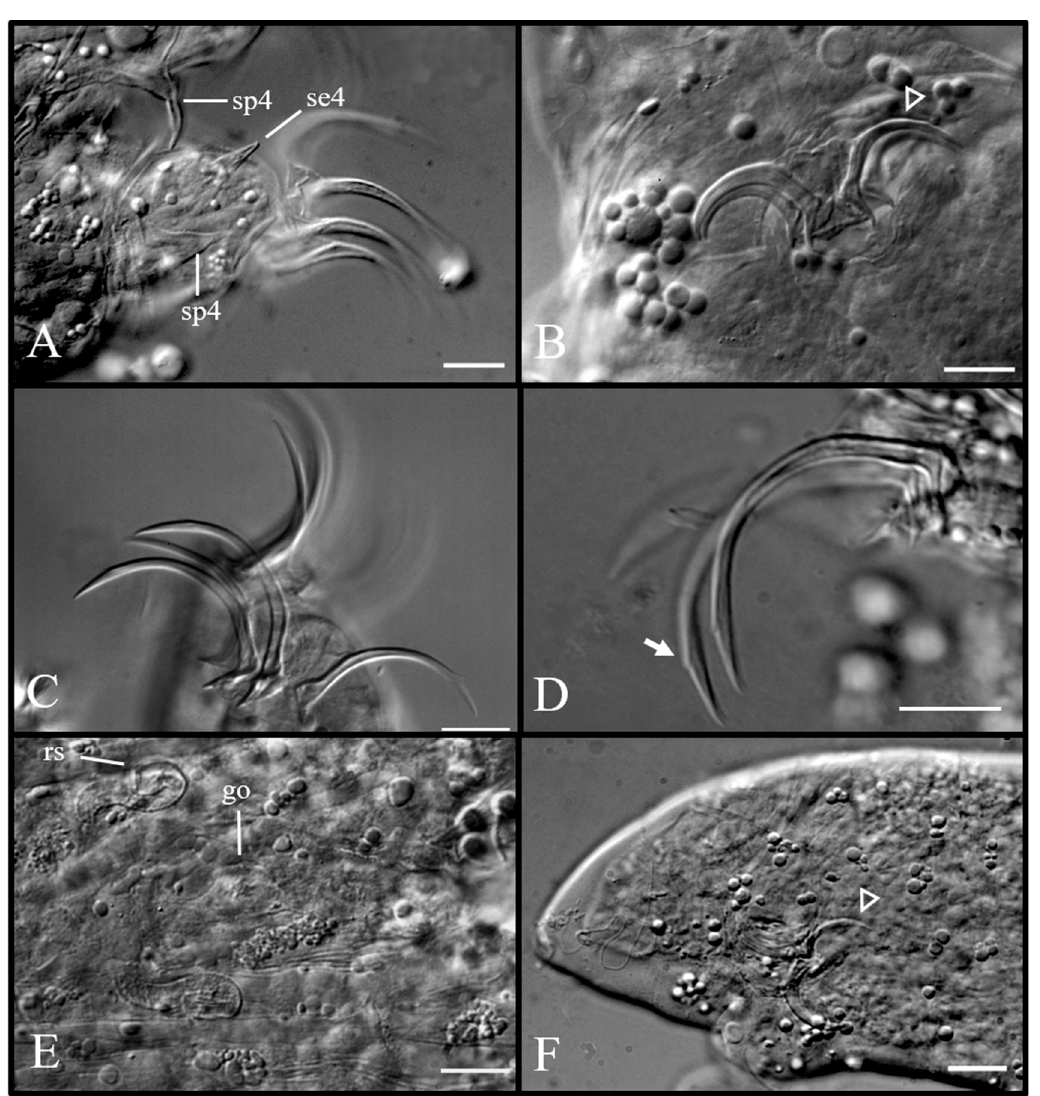
Figure 4. Coronarctus dissimilis sp. nov.; (A) Legs IV, showing the sensory organ and coxal processes; (B) Claws on legs I, notice the thinner most external claws (empty arrowhead); (C) Claws on legs IV; (D) Internal claws on leg IV, showing the accessory spine (arrow): (E) Female gonopore and seminal receptacles; (F) Larva, showing the thinner external claw (empty arrowhead). Abbreviations: go—gonopore; rs—seminal receptacle; se4—sensory organ on legs IV; sp4—coxal process on leg IV. Scale bars: 10 µm.